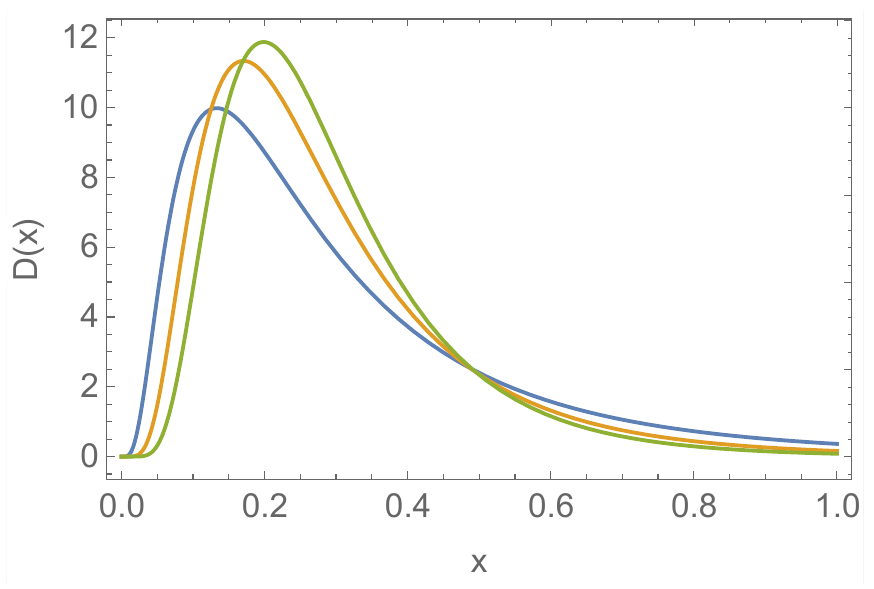
Figure 5 . Fragmentation function as a function of the energy fraction x for 500 GeV, for various choices of matching value x M . From bottom to top: x M = 0 : 07 , 0 : 10 and 0 : 13